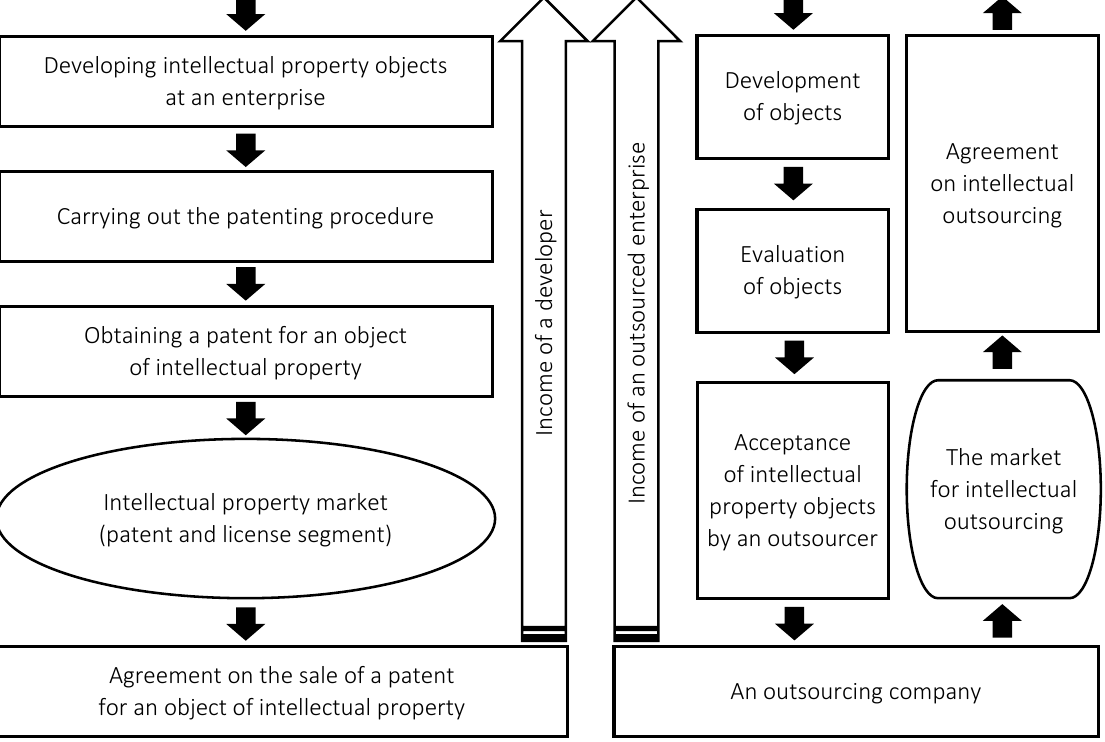
Figure 3. Horizontal commercialization of intellectual property